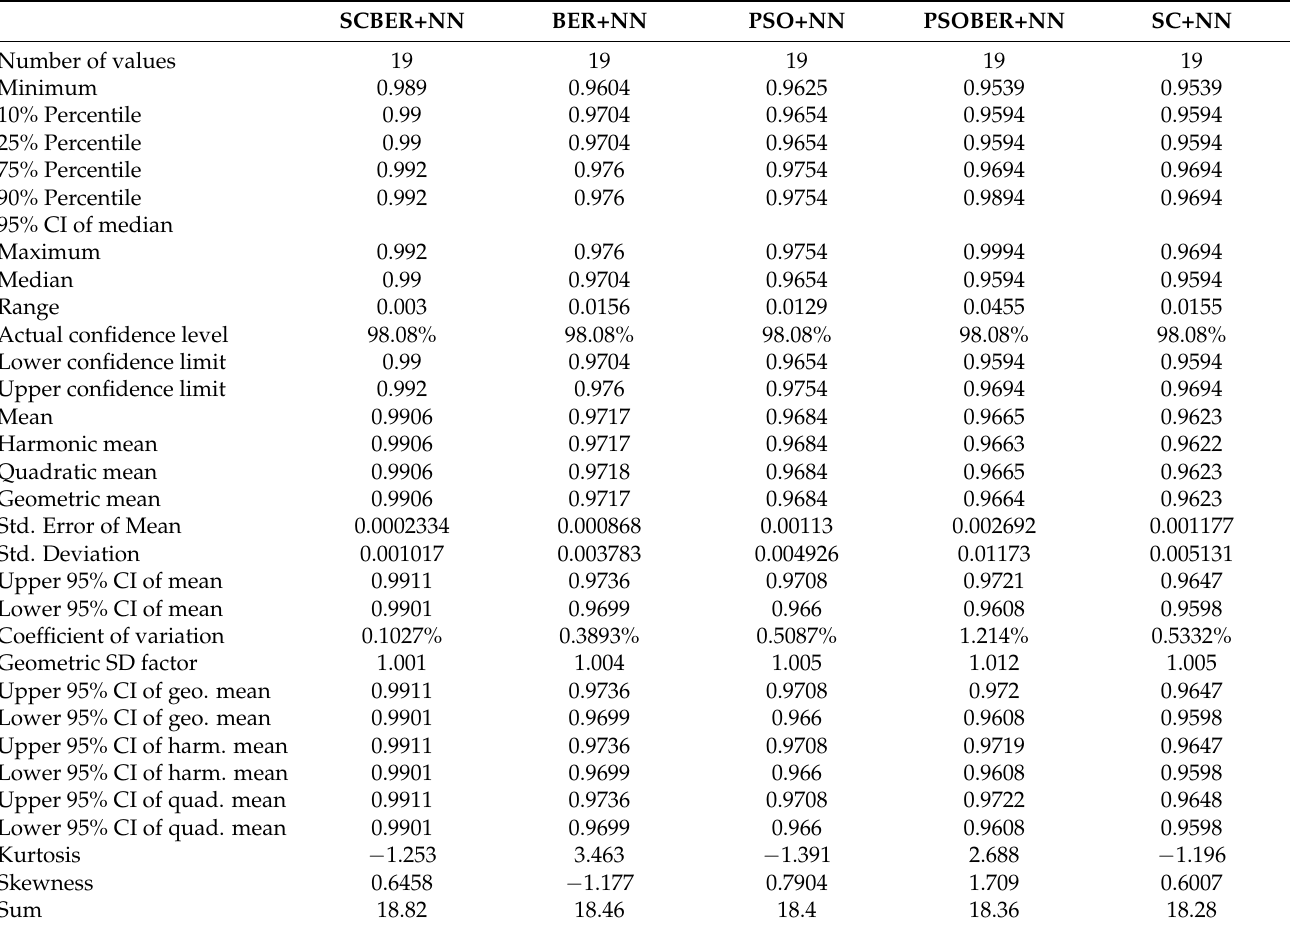
Table 11. Statistical analysis of the results achieved by the optimized neural network using